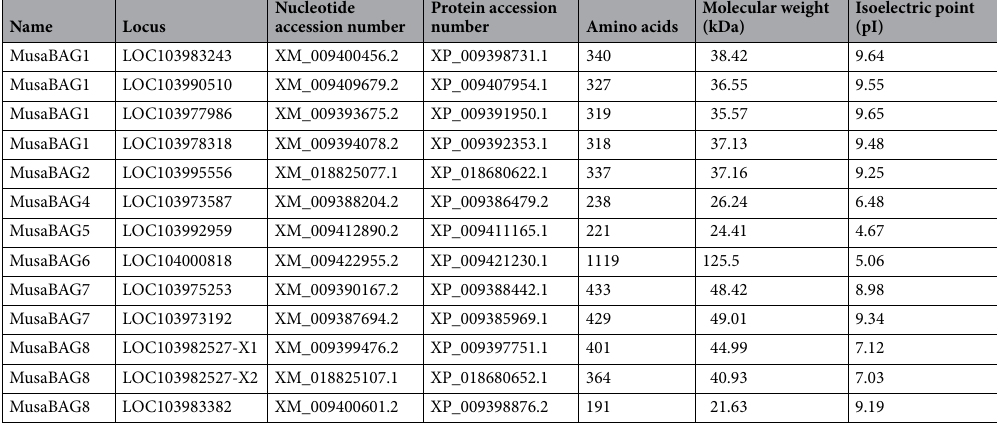
Table 1. Annotation, accessions, amino acids, molecular weight and pI of MusaBAG